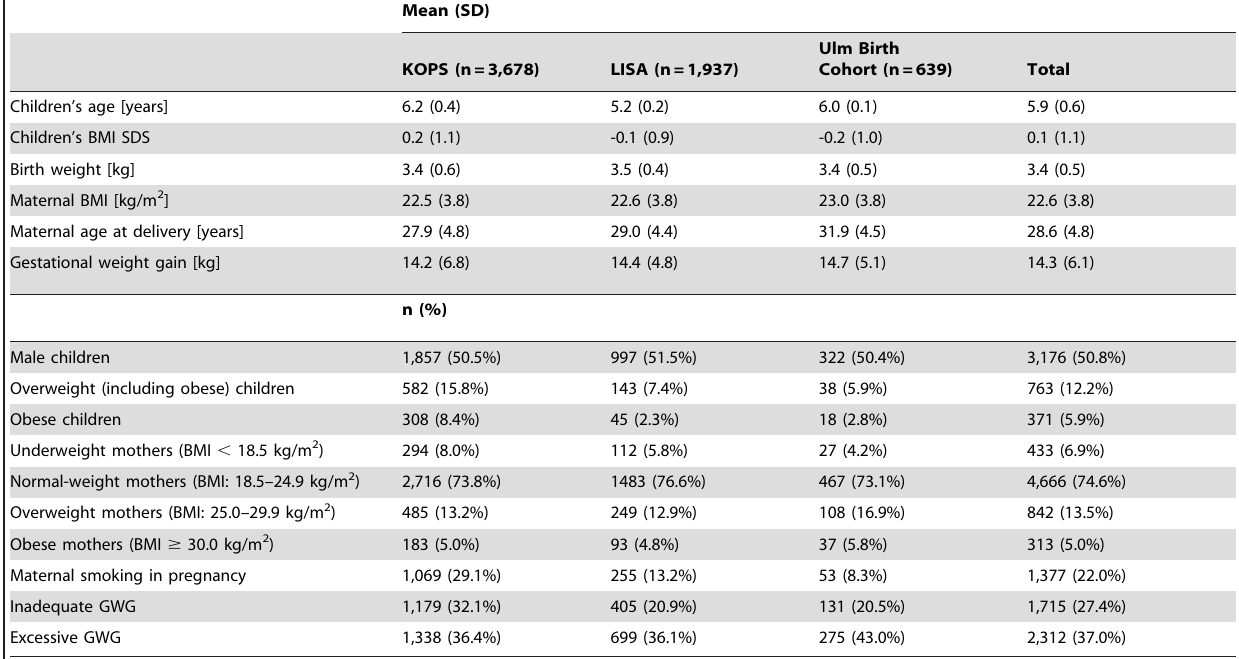
Table 1. Description of the study population (total: n=